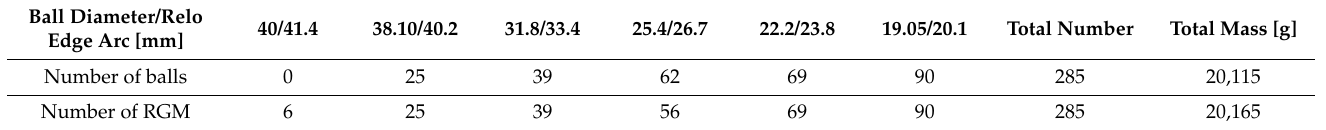
Table 3. Bond mill media charge—equal total mass, 10% greater surface area.